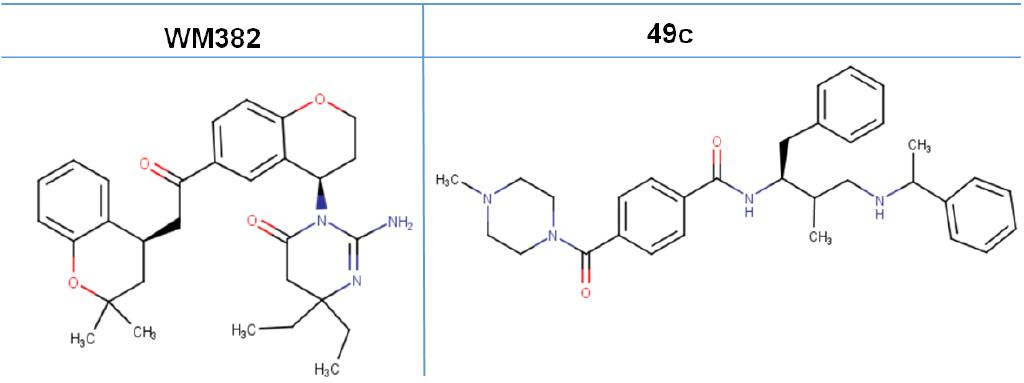
Figure 6. chemical structure of non-food vacuole aspartyl acid protease inhibitors, WM382 and 49c [30].